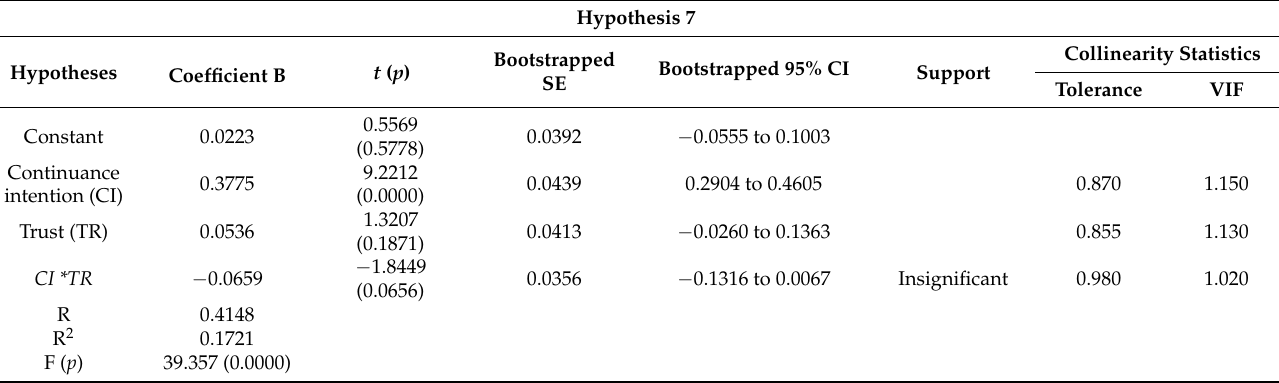
Table 10. Moderator regression analysis (testing hypothesis